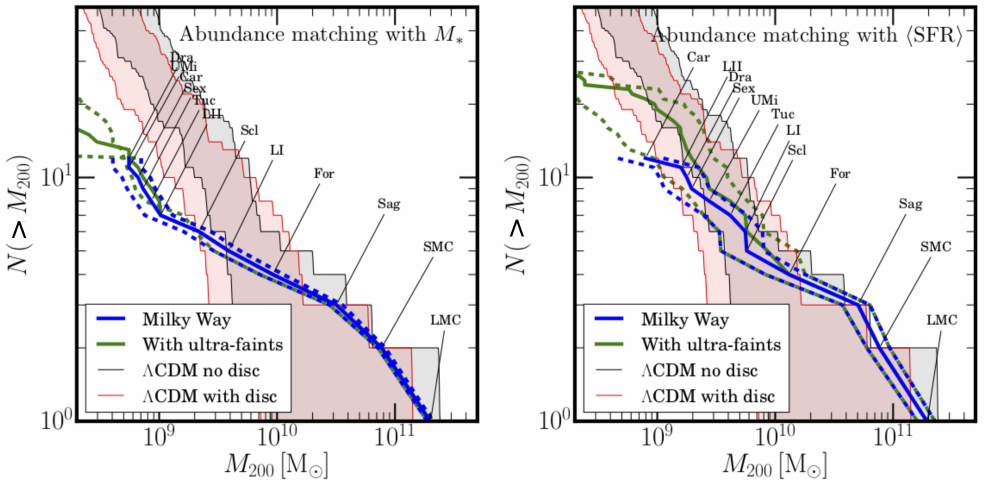
Figure 10. Complementary cumulative subhalo mass function of the Milky Way satellites in a sphere of radius 280 kpc centered on the Galaxy. The mass function is derived from either the M ∗ − M 200 AM relation ( left panel ) or the (cid:104) SFR (cid:105) − M 200 AM relation ( right panel ). The peak masses before the infall are taken as the subhalos masses M 200 . The names of the individual galaxies used to build the complementary cumulative subhalo mass functions are indicated in the plots. The median relations are shown as blue solid lines, whereas the ± 68% confidence intervals are delimited by the blue dashed lines. The green lines have the same meaning as the blue lines, but they also include the sample of ultra-faint dwarf galaxies of [178]. The grey shaded areas represent the variation of the complementary cumulative subhalo mass functions resulting from ten dark-matter-only “zoom-in” simulations of the Milky Way in the Λ CDM model. The red shaded areas have the same meaning as the grey shaded areas, but they include a model for the stellar disk of the Milky Way. The figure is from [257]. Here, we corrected the misprint that is present in the label of the ordinate axis of the original